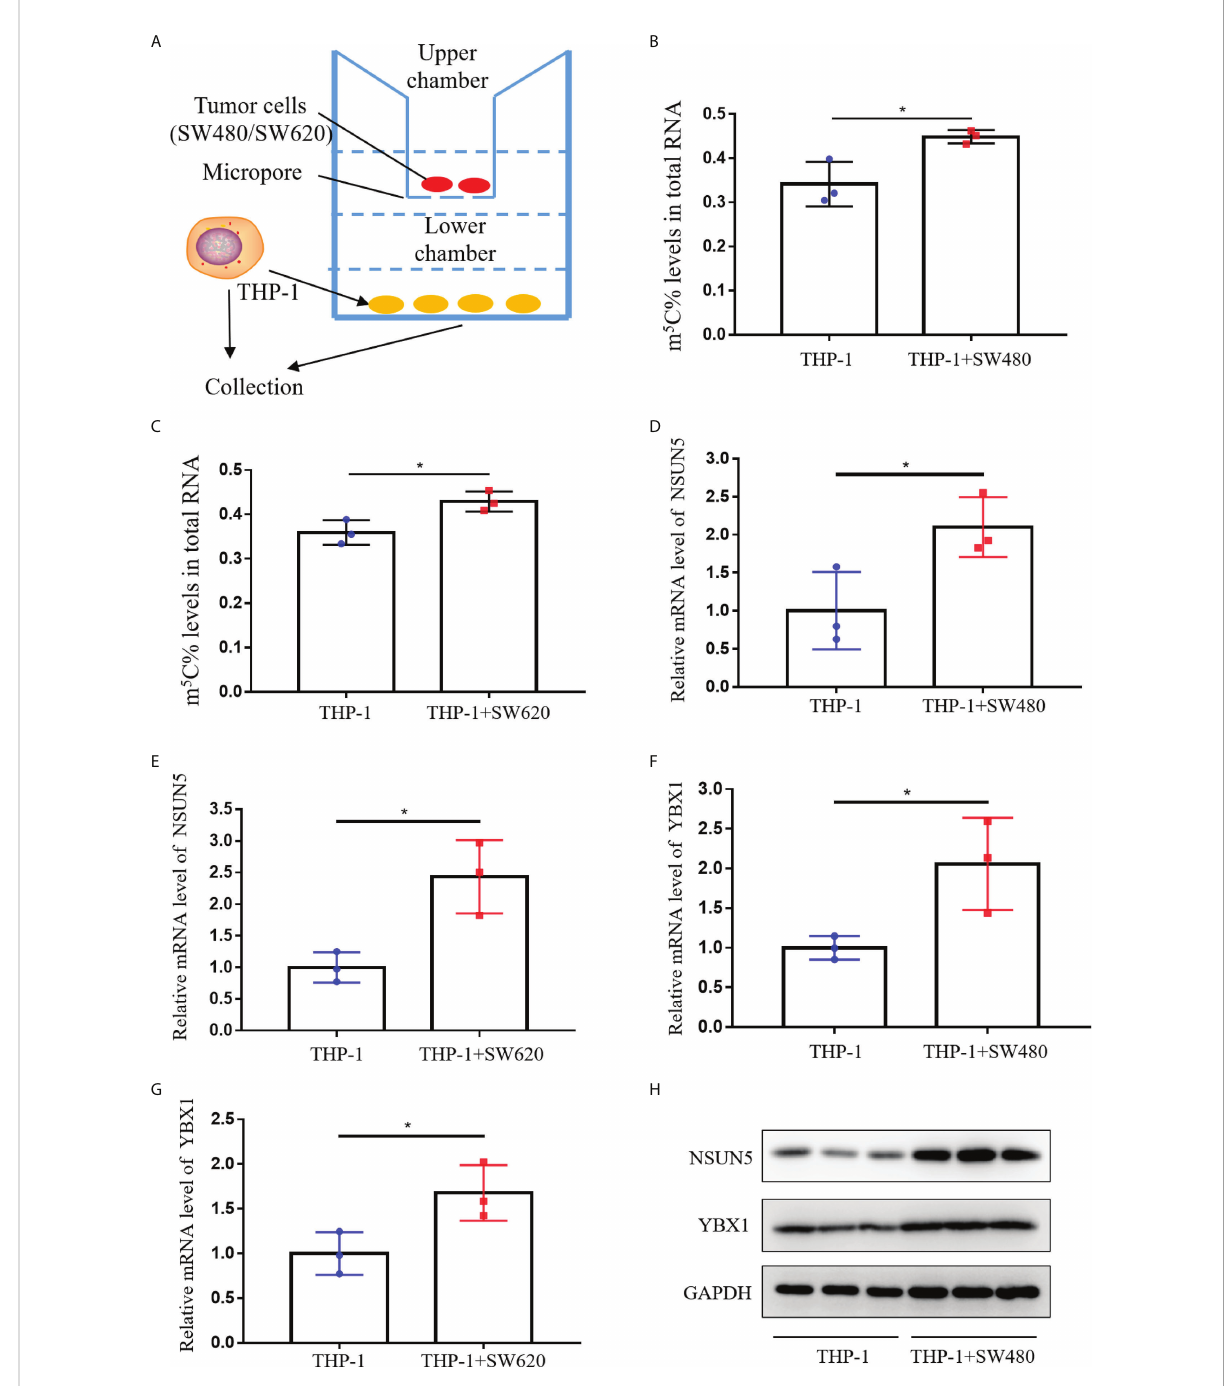
FIGURE 6 Levels of m 5 C and regulator in monocyte co-culture with CRC cells. (A) Schematic representation of the co-culture model of THP-1 and CRC cells. (B) Comparison of m 5 C levels between THP-1 with and without SW480 co-culture. (C) Comparison of m 5 C levels between THP-1 with and without SW620 co-culture. (D, E) qRT-PCR analysis of NSUN5 mRNA expression levels in THP-1 with SW480 (D) or SW620 (E) co-culture. (F, G) qRT-PCR analysis of YBX1 mRNA expression levels in THP-1 with SW480 (F) or SW620 (G) co-culture. (H) Western blot analysis of NSUN5 and YBX1 protein expression in THP-1 with or without SW480 co-culture. Data are shown as mean ± SD; * P <